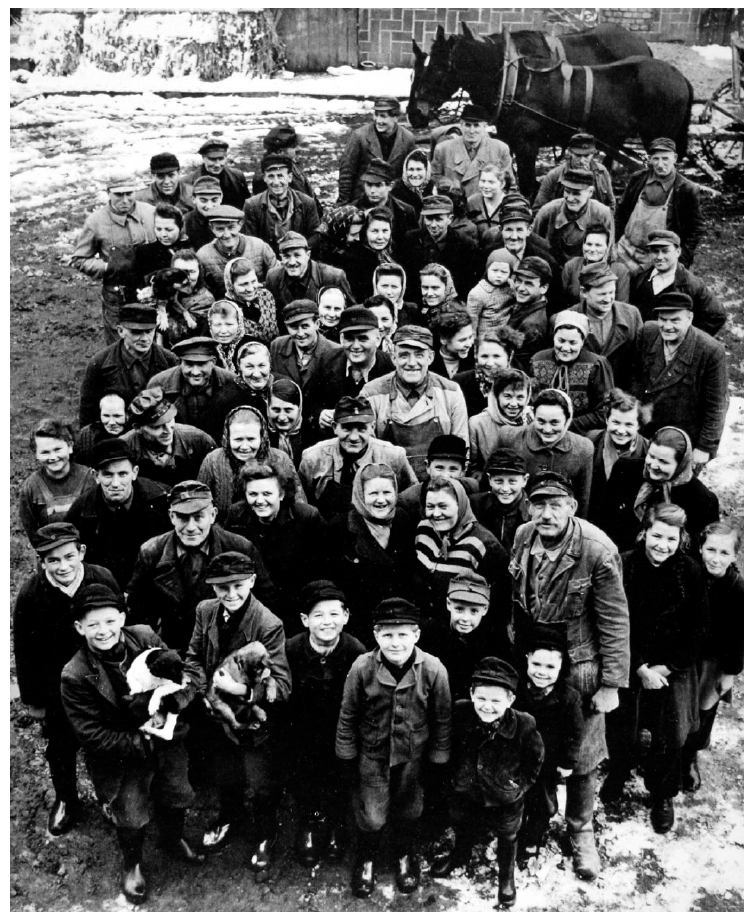
Figure 2. Gerhard Kiesling, LPG (Landwirtschaftliche Produktionsgenossenschaft) Fienstedt/ Bezirk Halle (LPG (Agricultural Production Cooperative) Fienstedt/ district Halle), 1953. Photo Credits: bpk/Gerhard Kiesling.